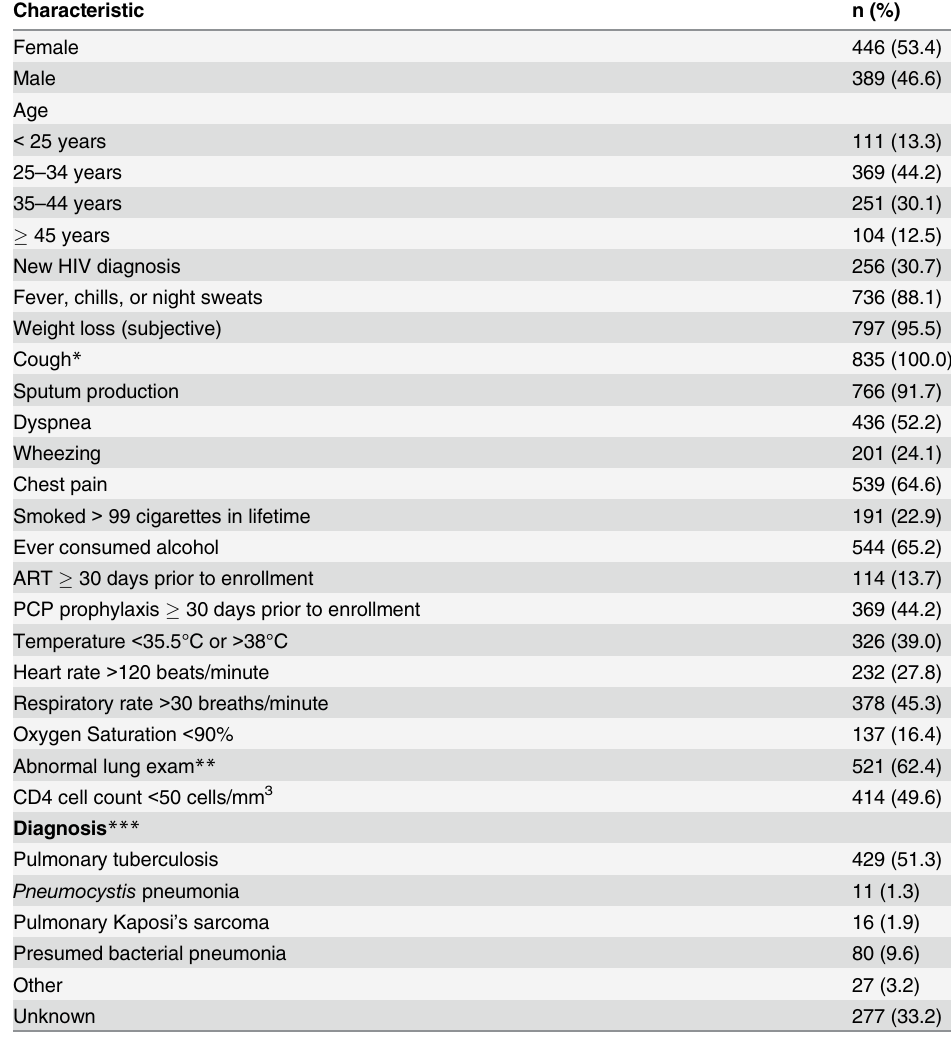
Table 1. Baseline characteristics and final diagnoses of 835 subjects.